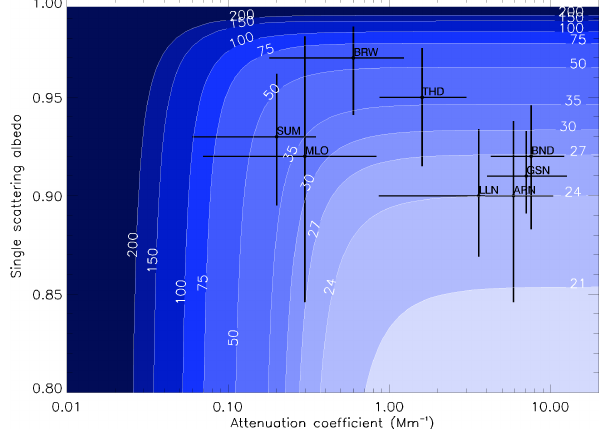
Figure 7. Uncertainty of CLAP measurements of the attenuation coefficient as a function of averaging time and attenuation coeffi- cient, expressed as the 95% confidence level.